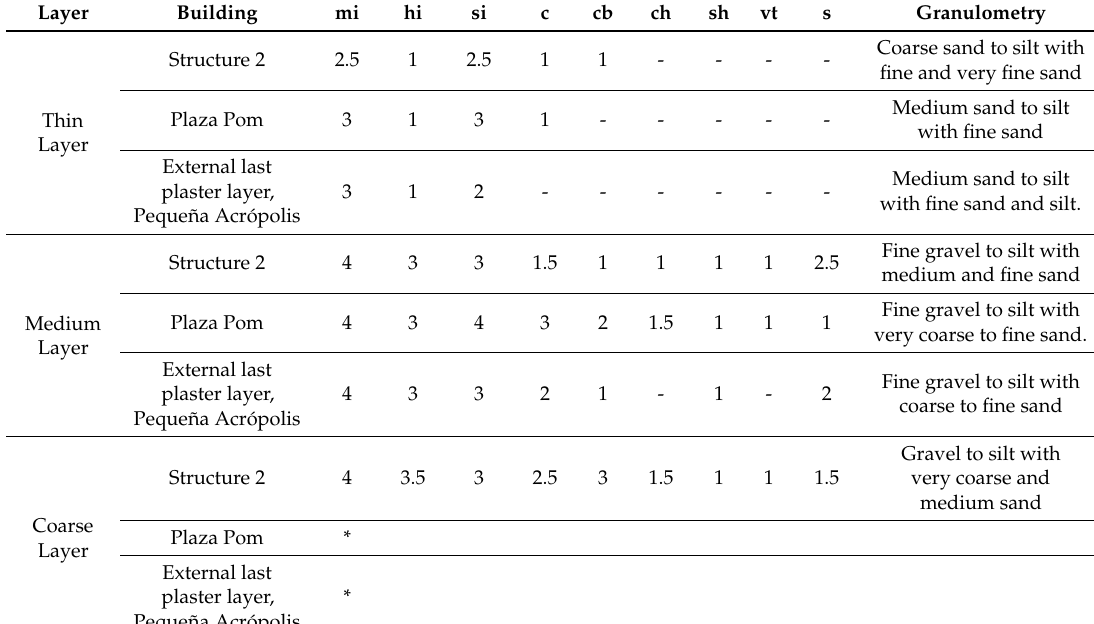
Table 4. Average frequency of inclusions in all the layers of Type 1 plasters. mi (micritic inclusions); hi (heterogeneous inclusions); si (sparitic inclusions); c (clays); cb (carbon); ch (chert); sh (shells); vt (vegetal tissue); s (soil). 1—very scarce (less than 5%); 2—scarce (5%–15%); 3—common (15%–40%); 4—frequent (40%–70%); 5—dominant (more than 70%). As we can see in Table 2, there is more than